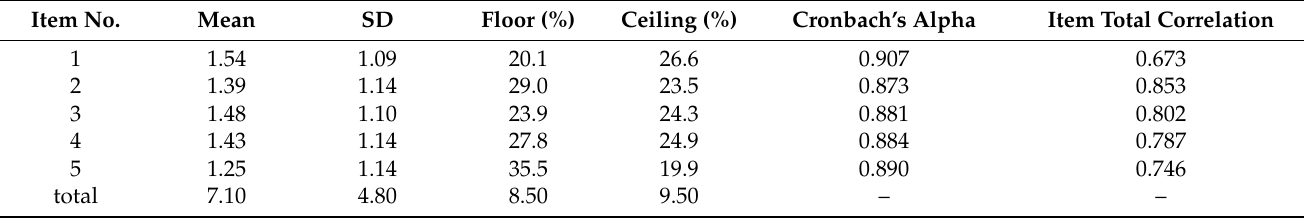
Table 3. Item statistics and internal consistency reliability of TCQ from Group